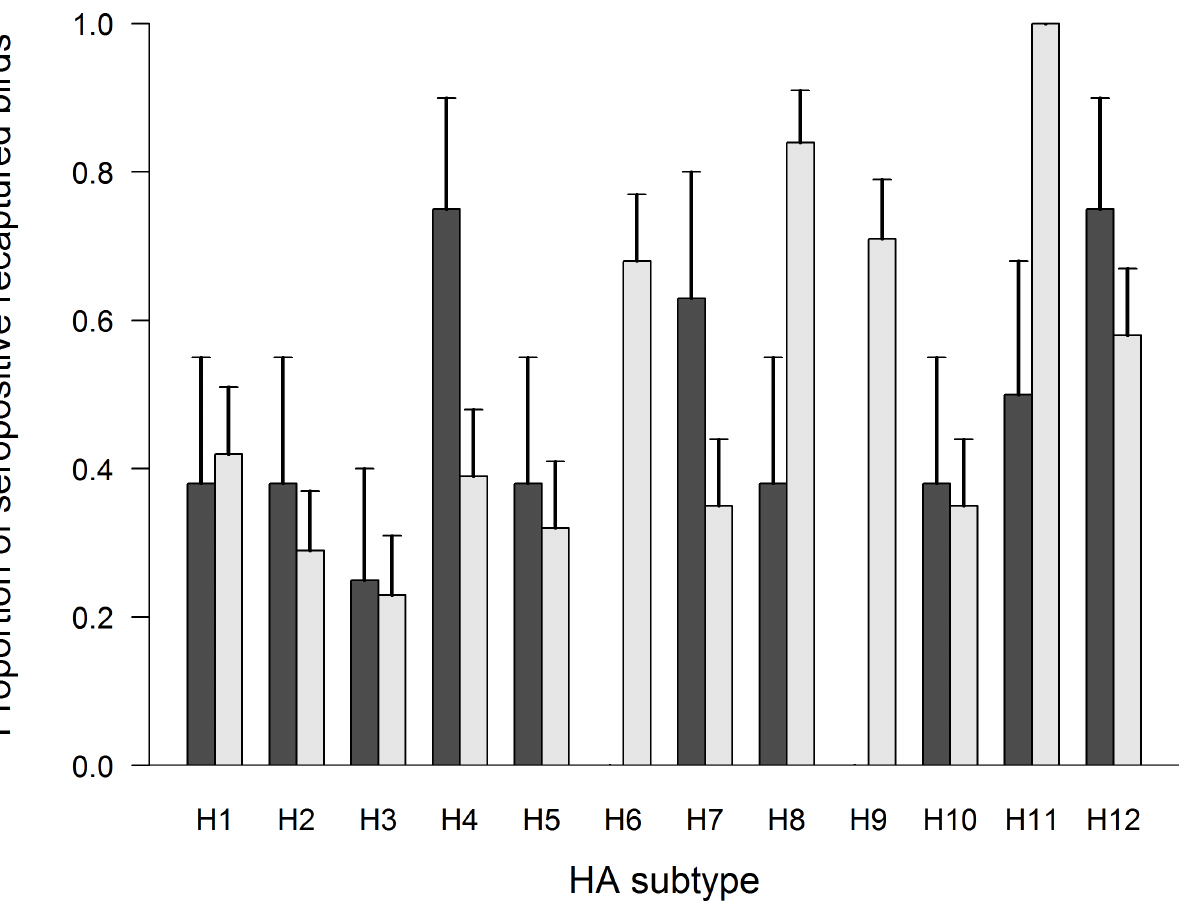
Fig 3. Subtype-specific antibody diversity to H1-H12HA influenza A viruses (IAVs) in mallards. Samples were collectedfrom mallards determined to be seropositive on multiple capture occasionsfrom August–April of 2012/13in Fairbanks(dark gray bars) and from mallards captured from September–April of 2014/15in Anchorage(light gray